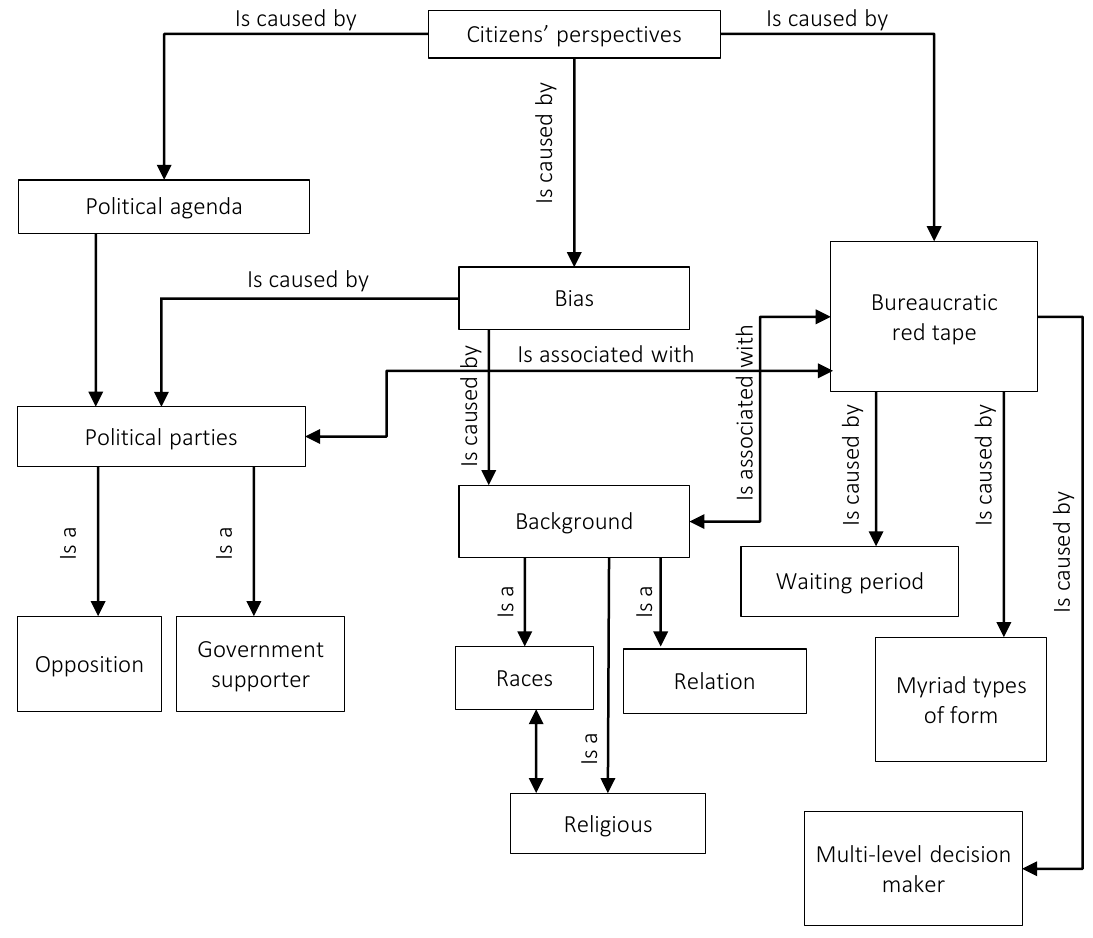
Figure 1. Integrity and enforcement frameworks from the citizens’